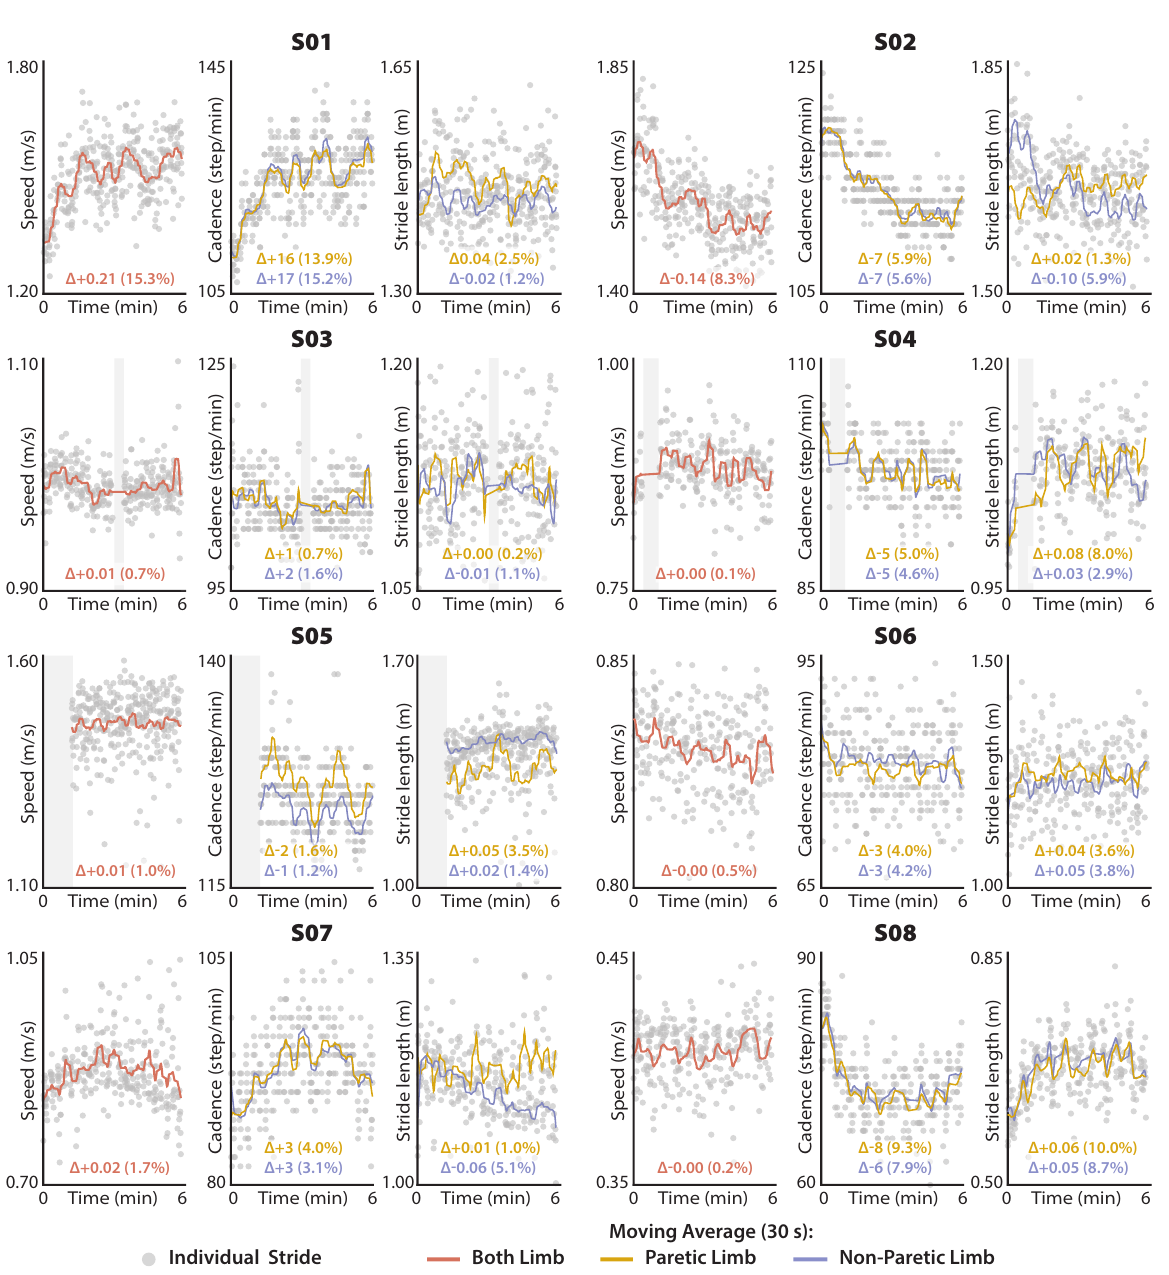
Figure 4. Distance-induced changes in speed, stride length, and cadence in post-stroke individuals. Reported ∆ s are the difference in the average from the last 30 s of walking and the first 30 s of walking. Regions highlighted in gray are missing